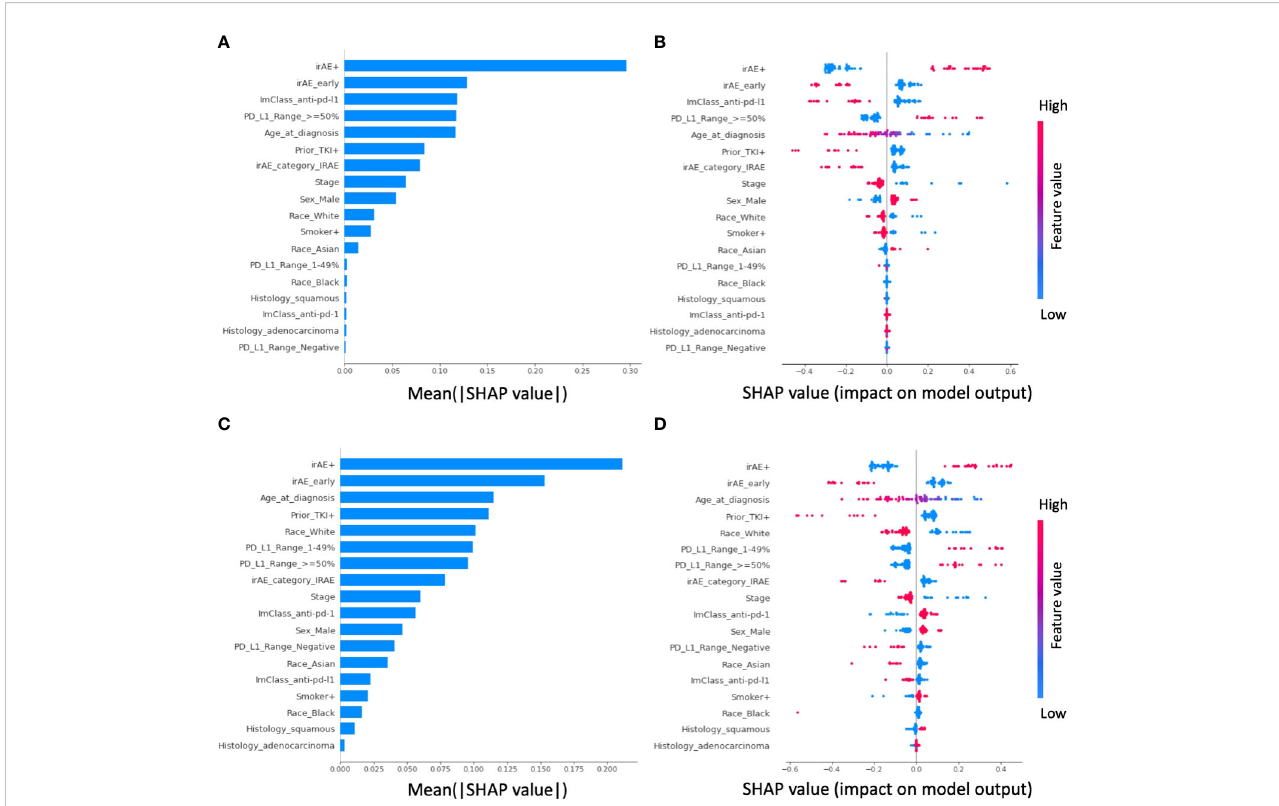
FIGURE 3 Shapley additive explanations (SHAP) analysis of feature importance in the elastic-net logistic regression-based prediction. For prediction of overall survival (OS) at 1 year, (A) shows the feature importance ranking from high (top) to low (bottom) based on the mean absolute SHAP values, whereas (B) shows the distribution and the impact of each feature on the model output. In the beeswarm plot, each row corresponds to one feature and each dot represents one patient ’ s data. The colors represent the feature value (red and blue for larger and smaller values, respectively). A positive SHAP value indicates the likelihood of having OS greater than 1 year increased, whereas a negative SHAP value indicate otherwise. For example, patients with irAEs (i.e., irAE+) have increased likelihood of OS greater than 1 year. For prediction of real-world progression free survival (rwPFS), the corresponding feature importance plot and the beeswarm plot is shown in panel (C, D) ,